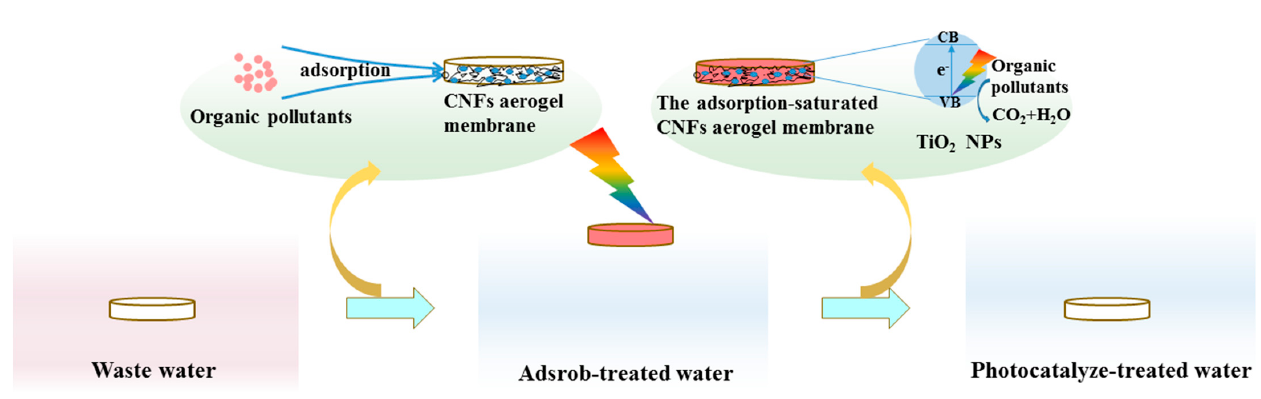
Figure 12. Schematic diagram of pollution treatment by TiO 2 @CNF Aerogel.